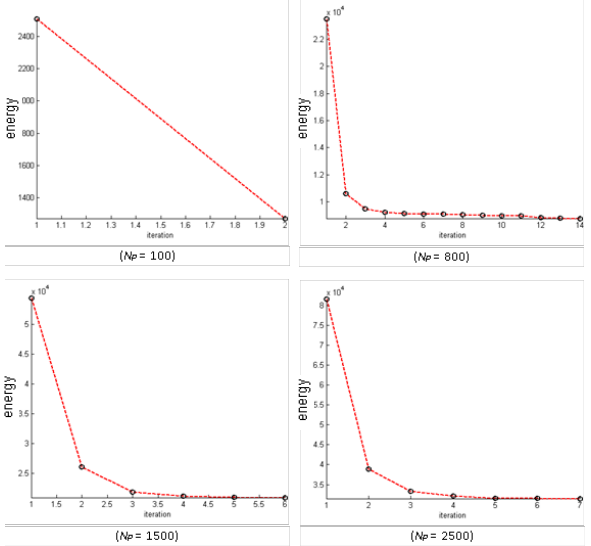
Figure 3.The energy graph decay in the condition of N P = [100, 800, 1500, 2500] for SAR intensity image (a) presented in Figure